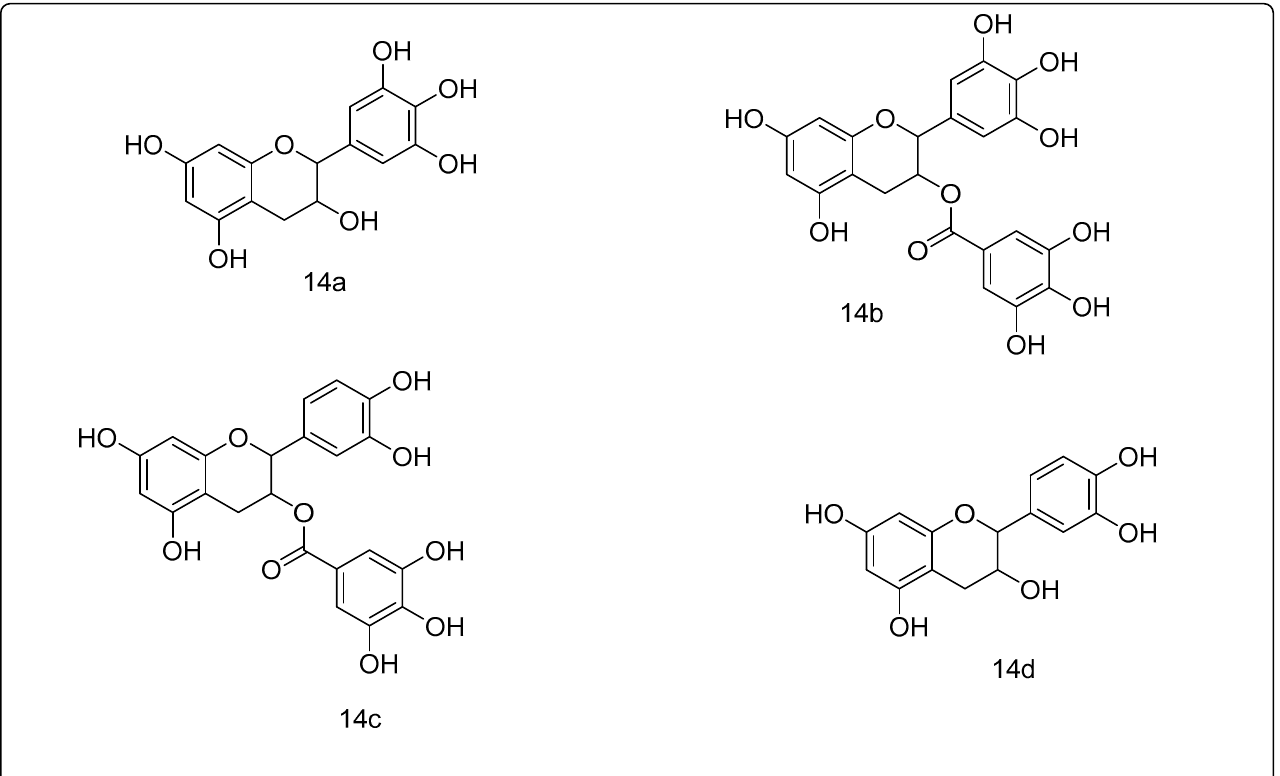
Figure 3. Green tea polyphenols: ( 14a ) epigallocatechin; ( 14b ) epigallocatechin gallate; ( 14c ) epicatechin gallate; ( 14d ) epicatechin.